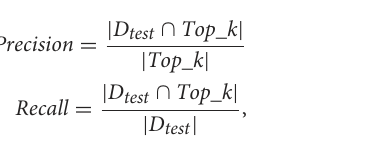
TABLE 1 Statistics of